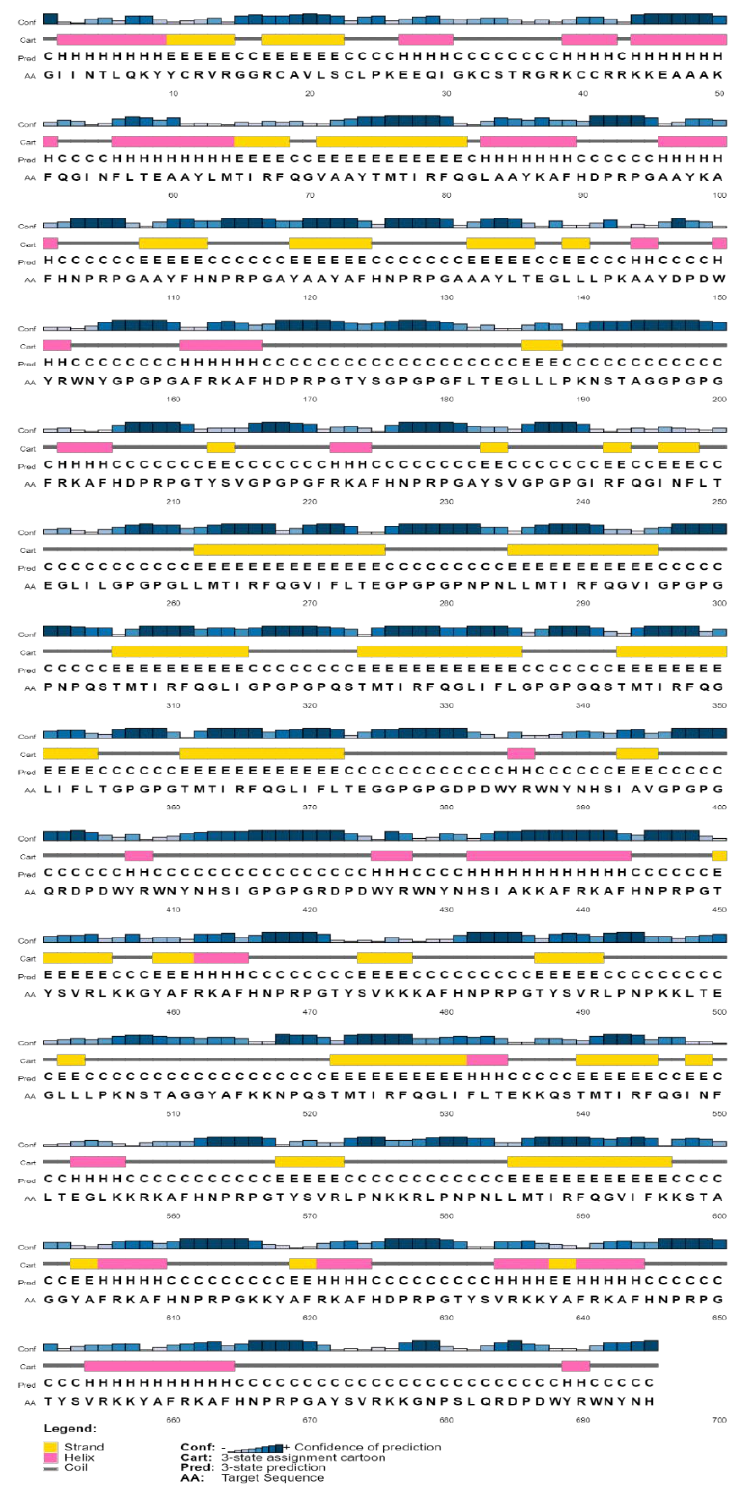
Figure 2. Secondary structure prediction of the MEV construct.